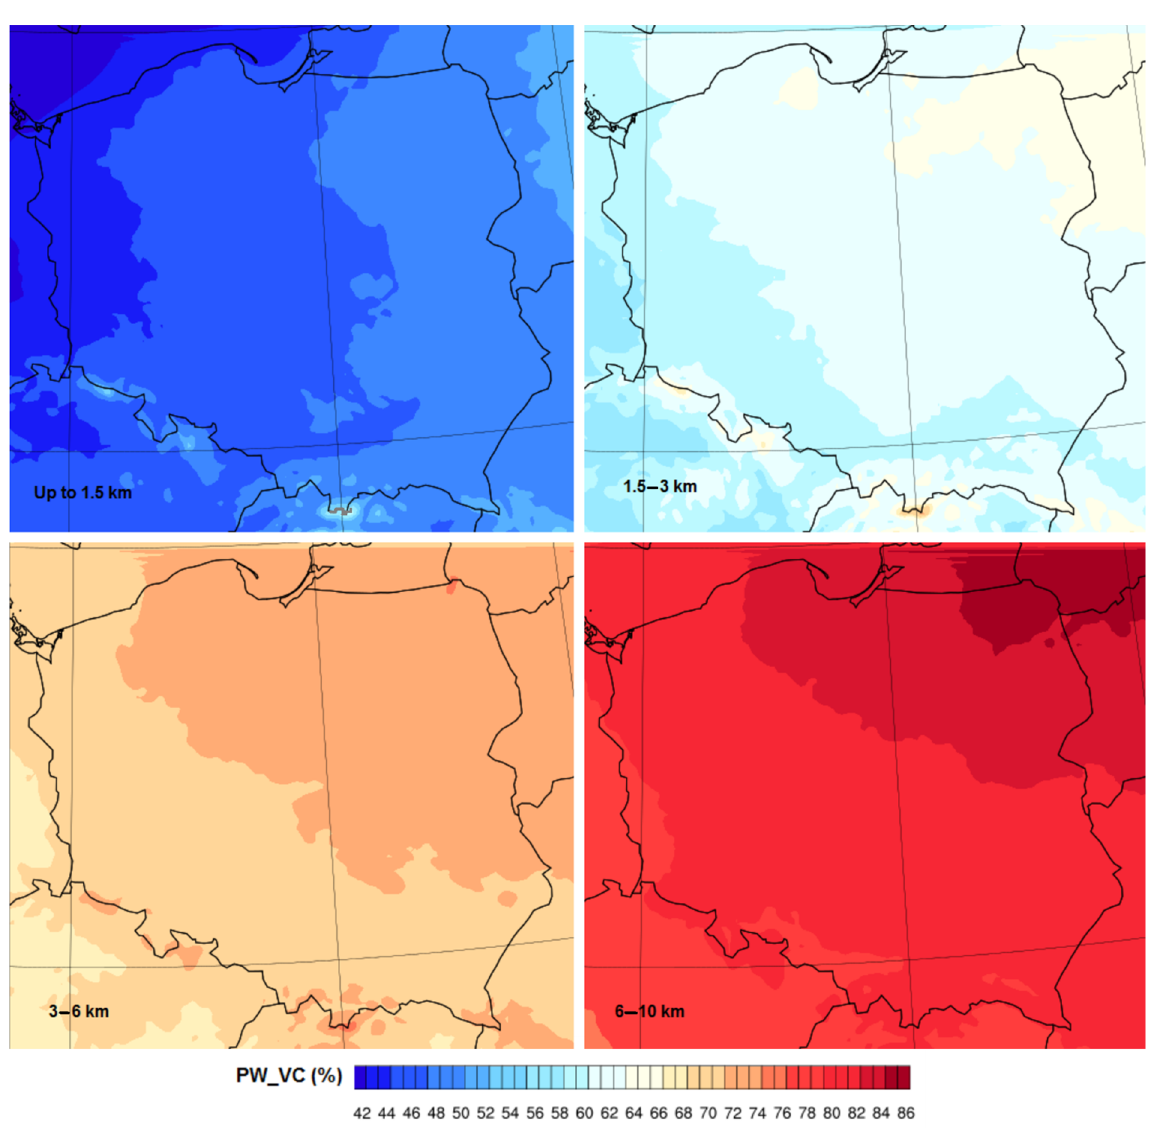
Figure 10. PW variability coefficient (%) between 1981 and 2010 over Poland at individual levels: up to 1.5 km, 1.5–3 km, 3–6 km and 6–10 km. Grids excluded from the analysis are in gray.